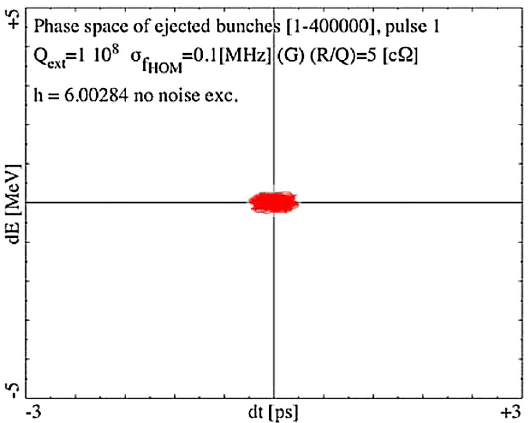
FIG. 45. (Color) Phase-space image of the ejected bunches of the second pulse. Conditions as Fig. 43 but Q ext ¼ 10 6 .